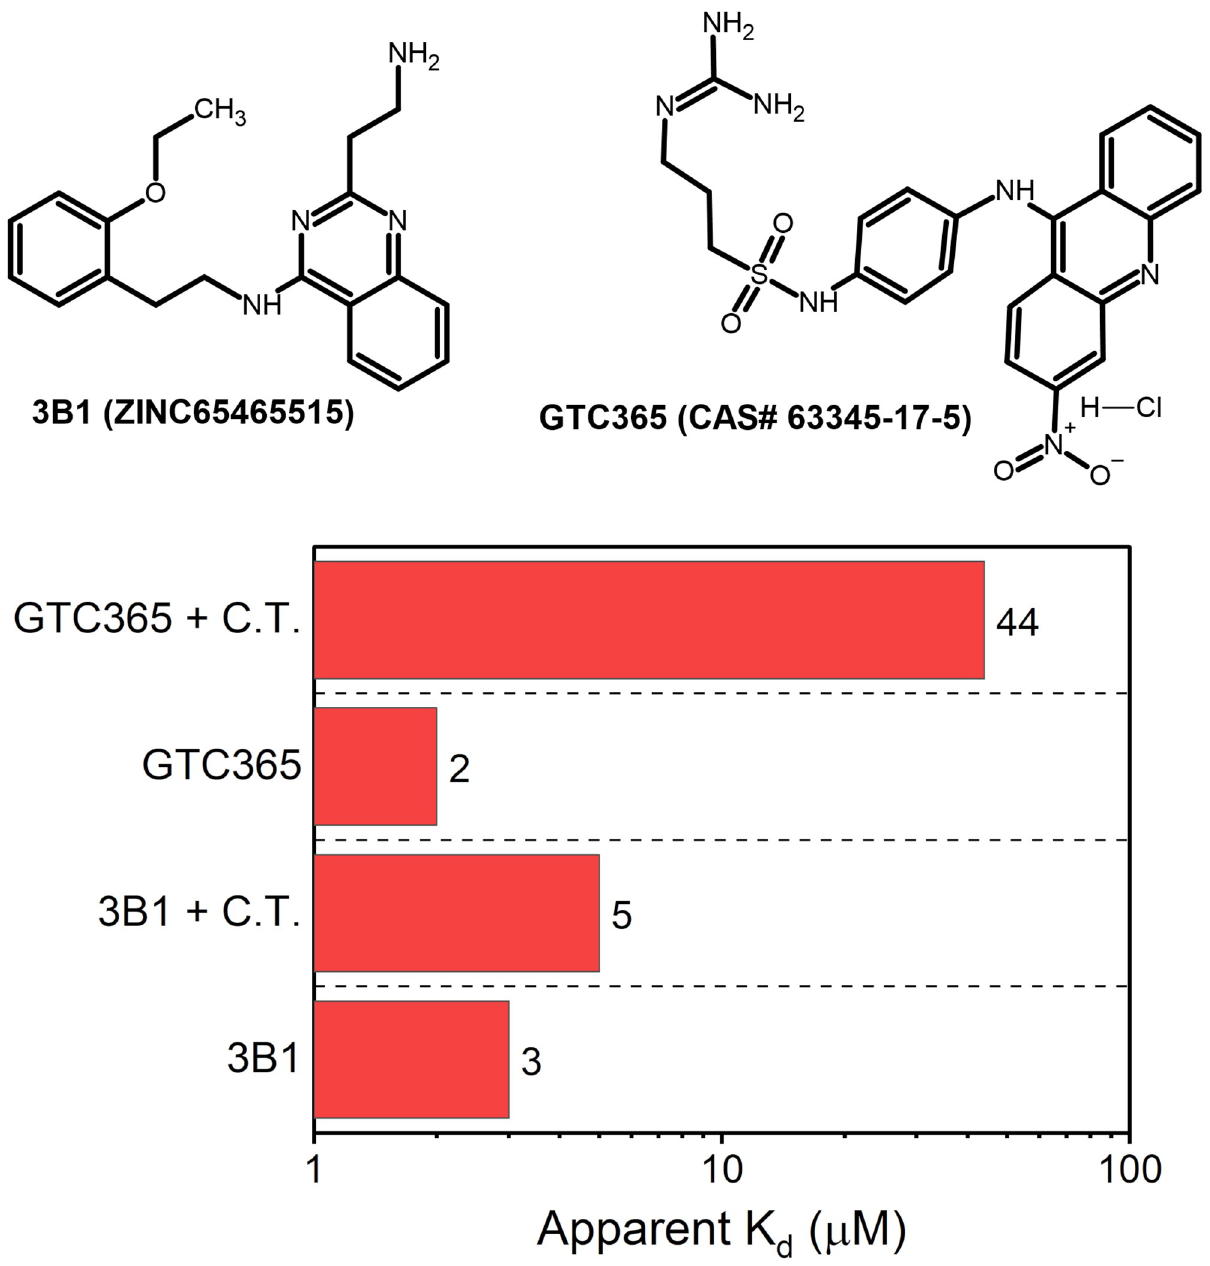
Fig 7. Comparison of 3B1 and GTC365. (Top) Molecular structures of compounds 3B1 and GTC365. (Bottom) Apparent dissociation constants (K d ) measured for 3B1 and GTC365 binding to Cy5-hTERT-FL in the presence or absence of 250 μ g/mL calf thymus (C.T.) DNA (approximately 500:1